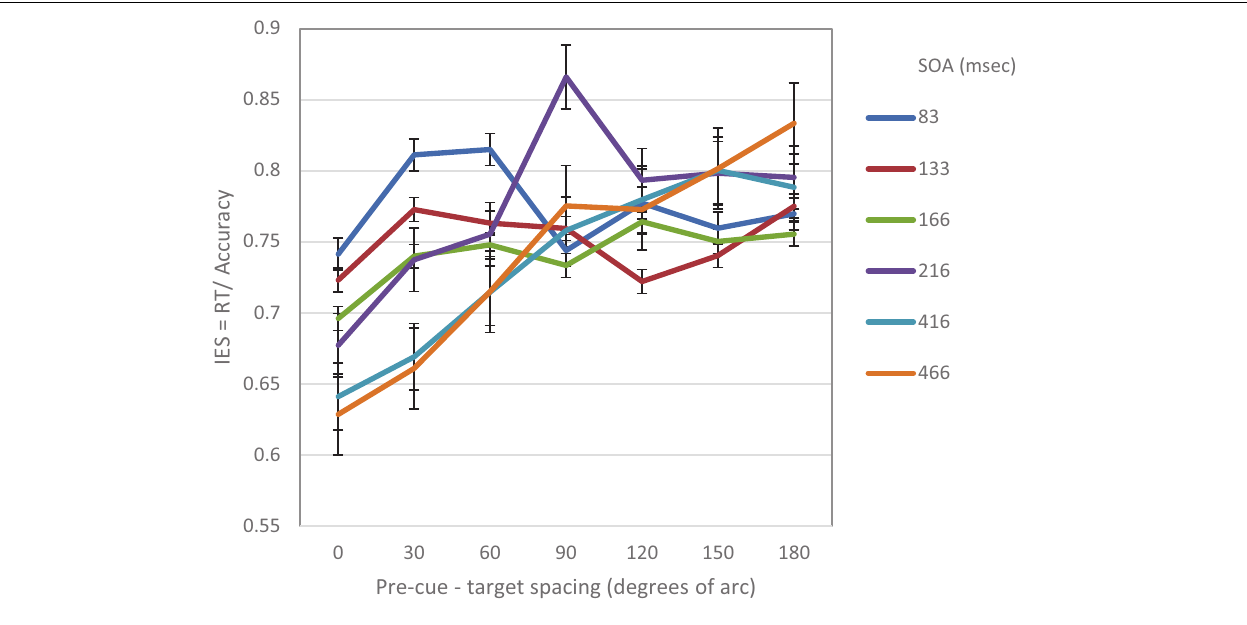
FIGURE 7 | IES curves in Experiment 1 and Experiment 2, as a function of pre-cue – target spacing and